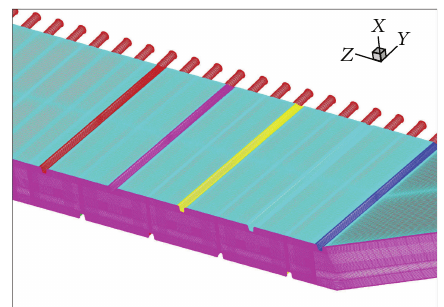
Figure 4: Mesh distribution around the rib-roughened section of the